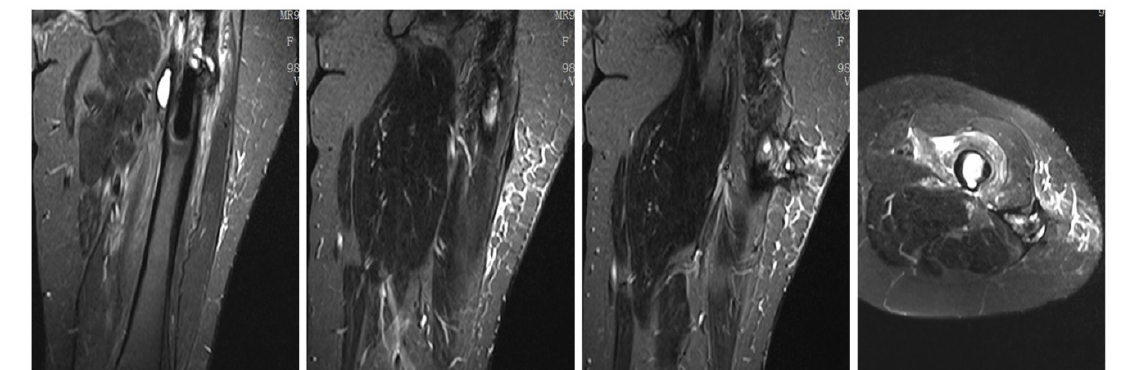
Figure 1. X-ray films show no sign of migration, but a periprosthetic defect at the anterior cortex of left femur from lateral view (white arrow).